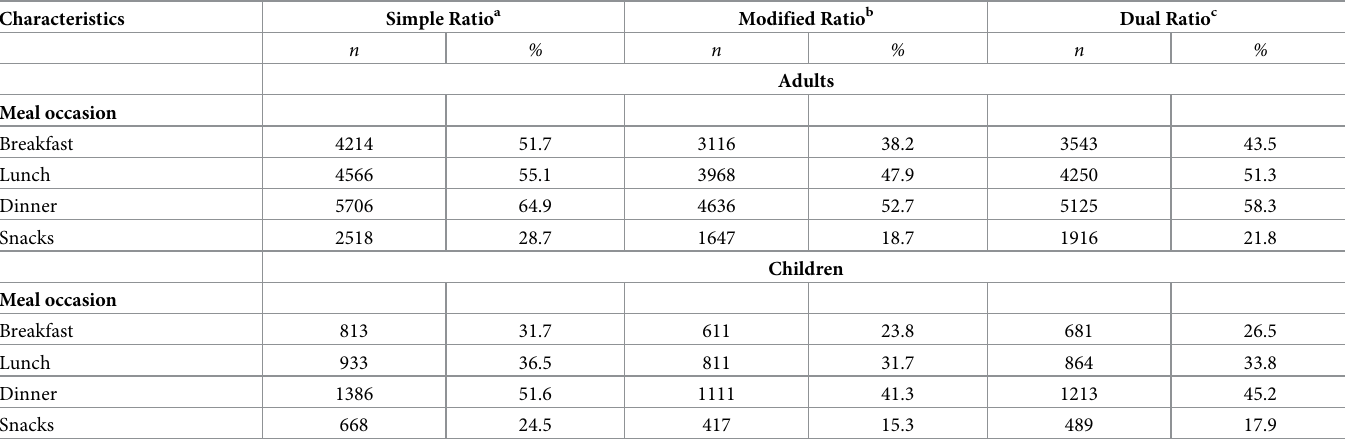
ent when comparing those who did and did not meet each ratio, while vitamin B12 was higher among those who met the modified and dual ratios but not the simple ratio (p < 0.001), despite similarities across ratios. Table 2. The proportion of participants in the 2011–12 Australian National Nutrition and Physical Activity Survey (NNPAS) who satisfied each carbohydrate qual- ity ratio, by meal occasion.